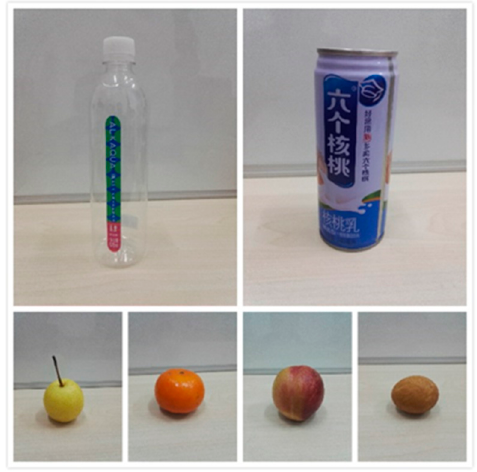
Figure 6. Optical photographs of objects for grasping